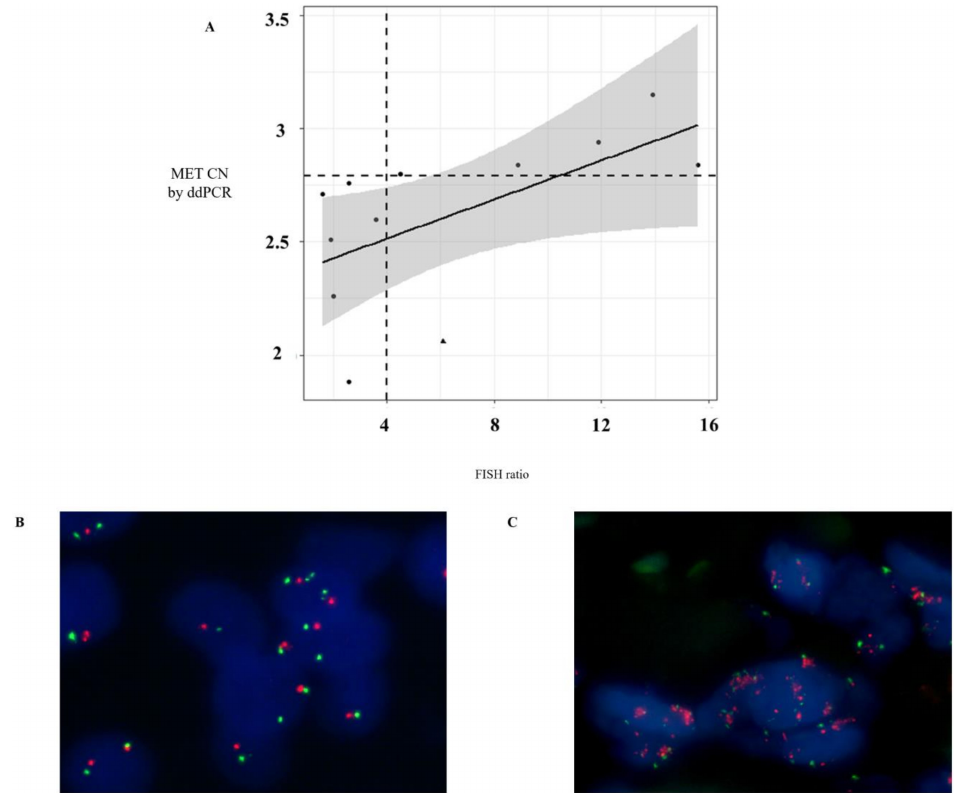
Figure 3. Comparison of MET CN status in tissue and cfDNA. ( A ) Distribution of MET CN measured by ddPCR and fluorescence in situ hybridization (FISH) (the point larger indicates the discordant value, whereas the horizontal and vertical dotted lines indicate cut-o ff points of ddPCR and FISH, respectively); ( B ) Representative example of a negative case for MET amplification obtained in a NSCLC patient by FISH; and ( C ) Representative example of a positive case for MET amplification obtained in a NSCLC patient by